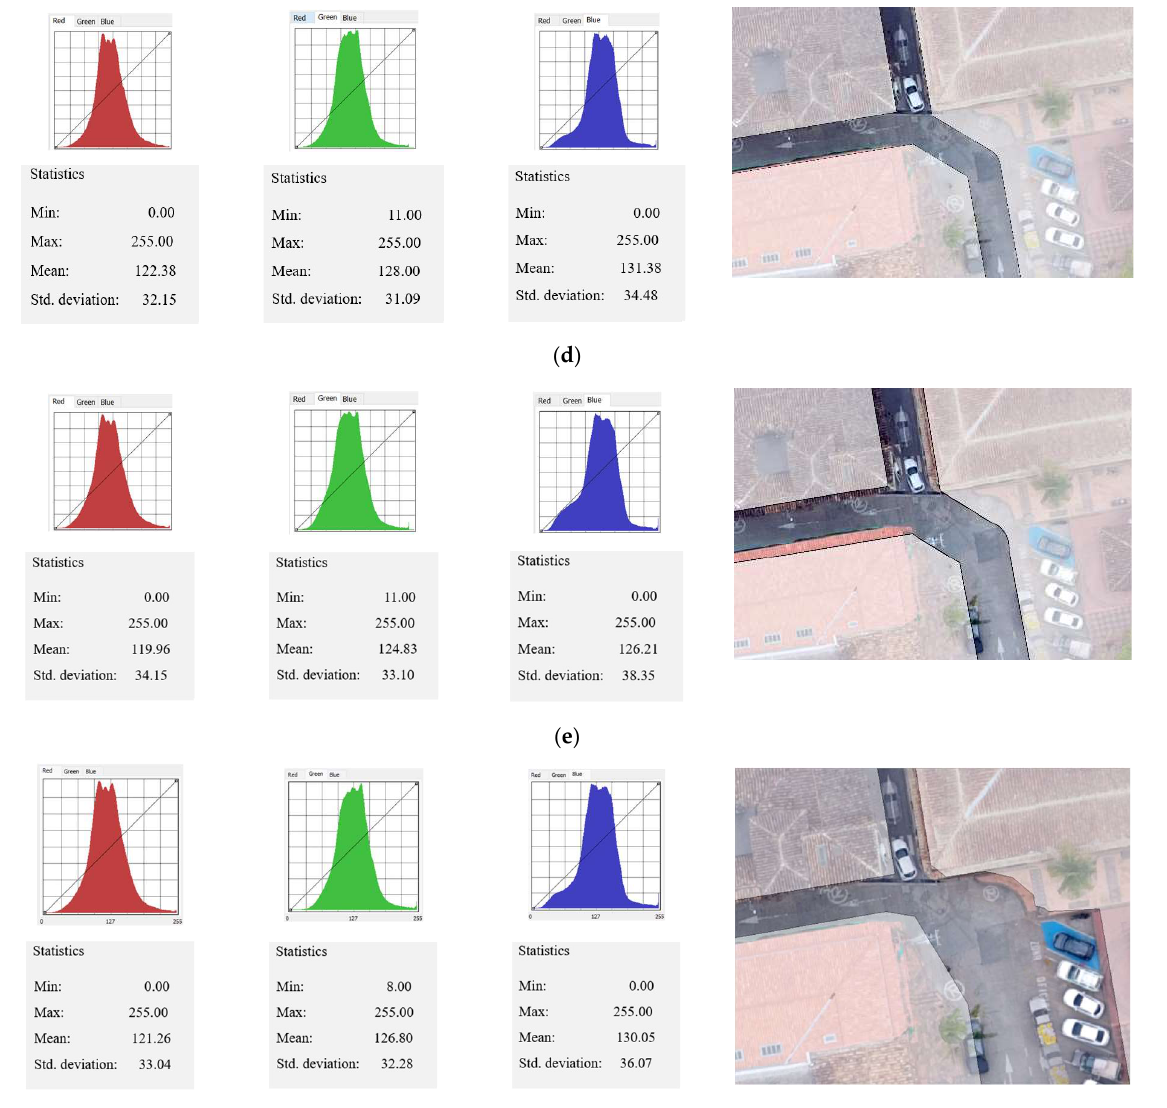
Figure 6. RGB pixel value distributions vs. mask buffer distance for roads dataset. ( a ) RGB distribution for the whole orthomosaic, imbalance = 8.03%, ( b ) 50 cm buffer distance, imbalance = 2.13%, ( c ) 1 m buffer distance, imbalance = 4.35%, ( d ) 2 m, imbalance = 7.86%, ( e ) 3 m, imbalance = 13.56%, ( f ) full-size mask, imbalance = 11.63%. The same experiment was performed over all orthomosaics, and the values are probably similar because the roads are of similar size and materials in the mapping zone.